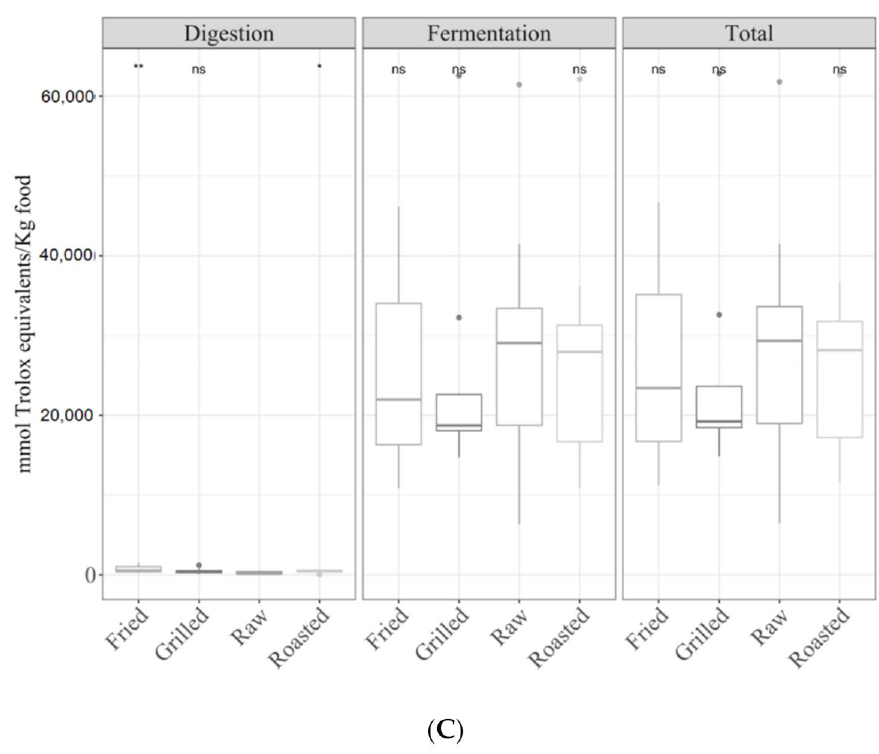
Figure 6. Antioxidant capacity of digested-fermented fruits depending on the type of cooking technique (( A ) TEAC DPPH , ( B ) Folin–Ciocalteu and ( C ) TEAC FRAP ). Statistical analysis was performed via ANOVA